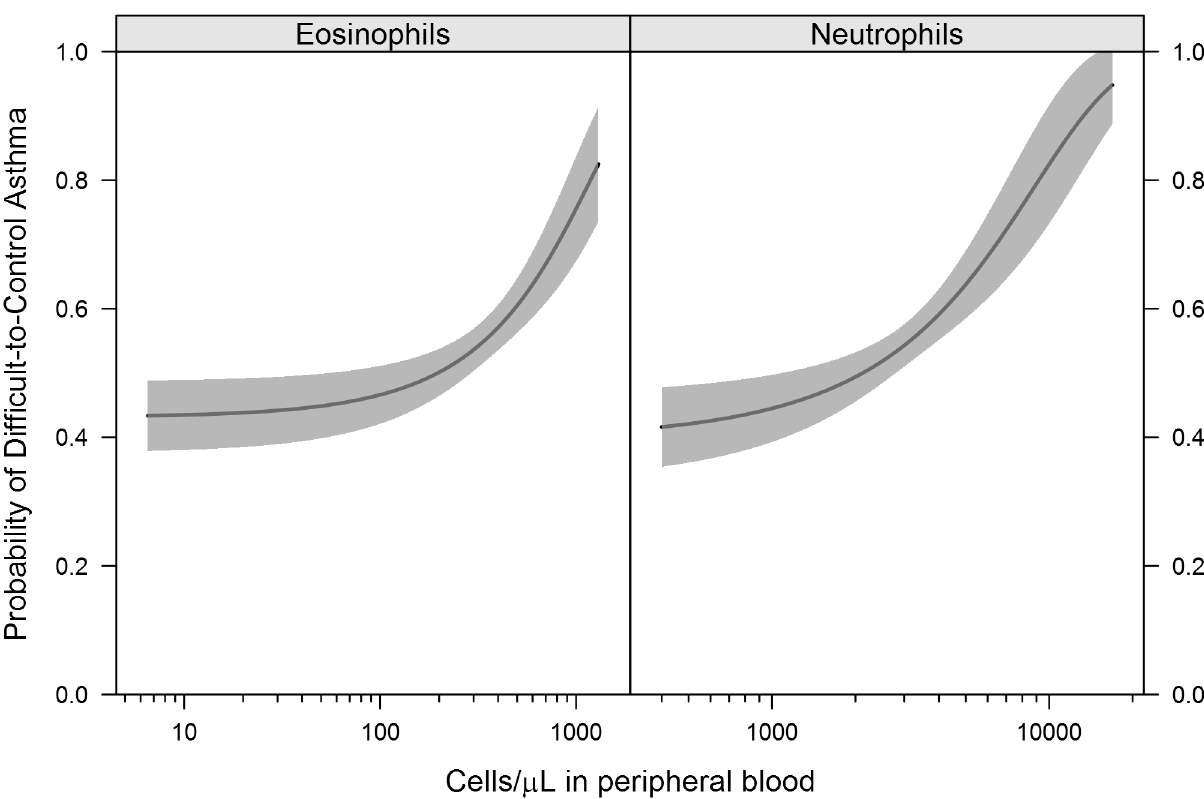
Fig 1. Probability of difficult-to-control asthma rises as blood eosinophil and neutrophil concentrations increase. Graphical representation of blood eosinophiland neutrophil concentrations and the probabilityof Difficult-to-Control asthma. Valuesfrom all 235 subjects in the analysisare included. The blood neutrophil and eosinophilcounts were not correlatedin this population (Pearson correlation= 0.11, p = 0.11).